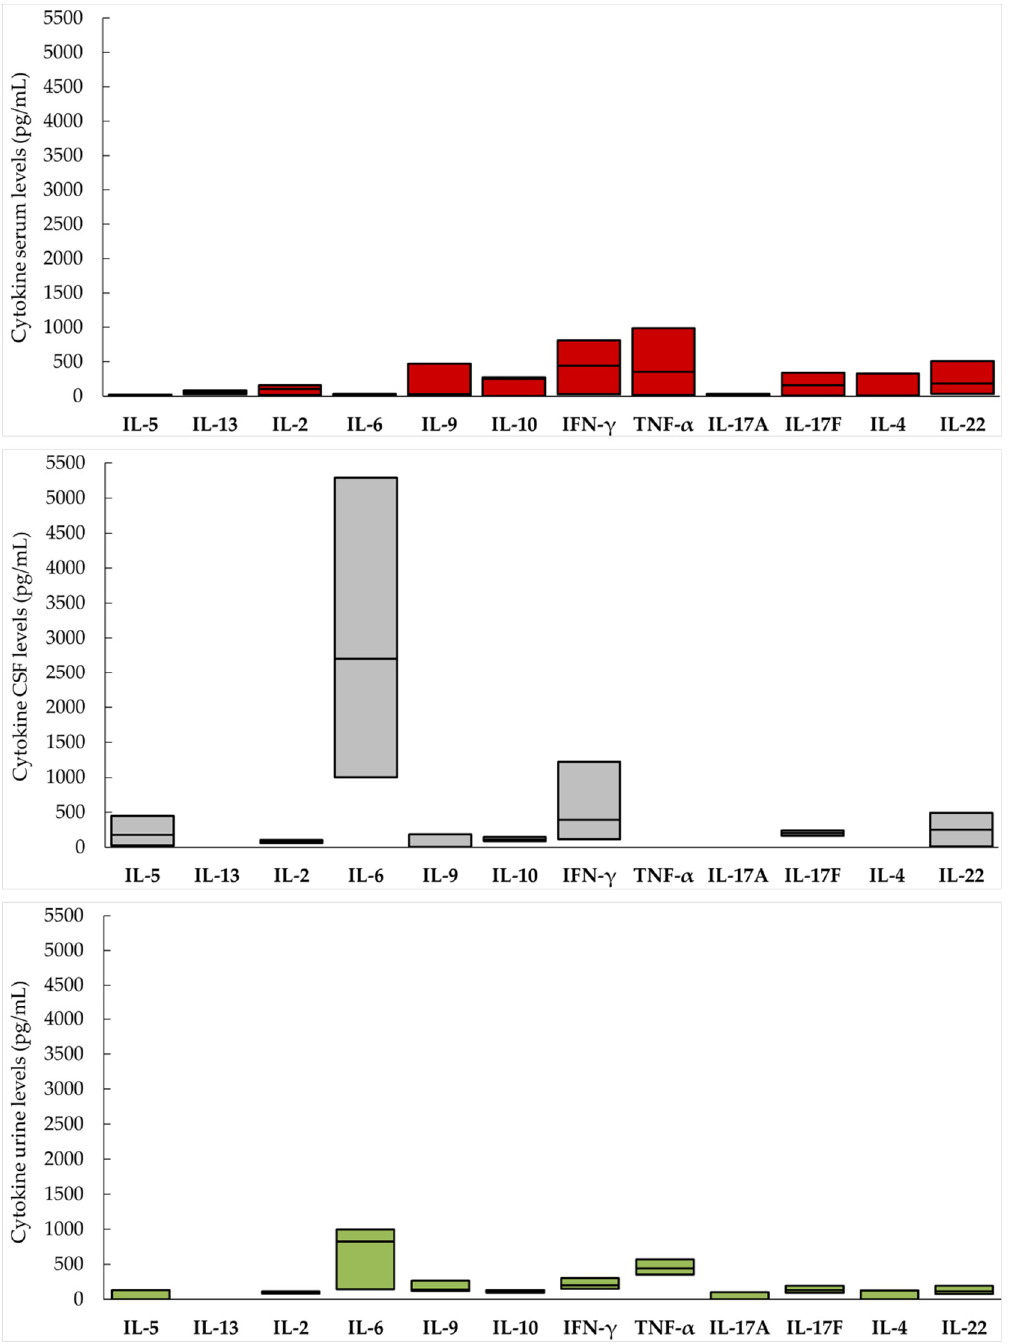
Figure 1. Cytokine levels in serum, cerebrospinal fluid (CSF) and urine of patients with TBE. Higher concentrations of cytokines in the CSF compared with serum, indirectly sug- gesting an intrathecal synthesis, were observed for several cytokines, including IL-5 (CSF median 181.1 pg/mL vs. 12.4 pg/mL), IL-6 (2705.7 vs. 23.9 pg/mL) and IL-22 (254.5 vs. 185.6 pg/mL).